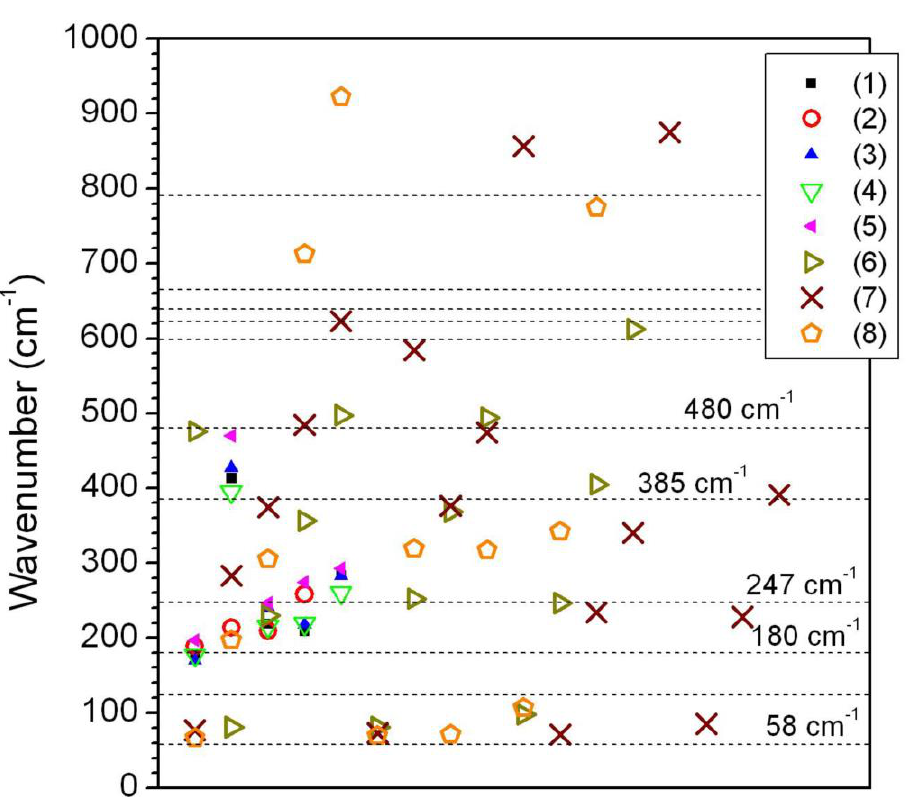
Figure 7. (Color online) Distribution of peaks in the Fourier power spectra of Figure 6. The Raman shift signals are plotted as dashed lines. The numbers in the legend refer to the caption of Figure 2. The marks indicate the vibrational modes found in Figure 6 and the ordinate indicates the frequency in wavenumbers.